Question: Does the plotted quantity increase or decrease?
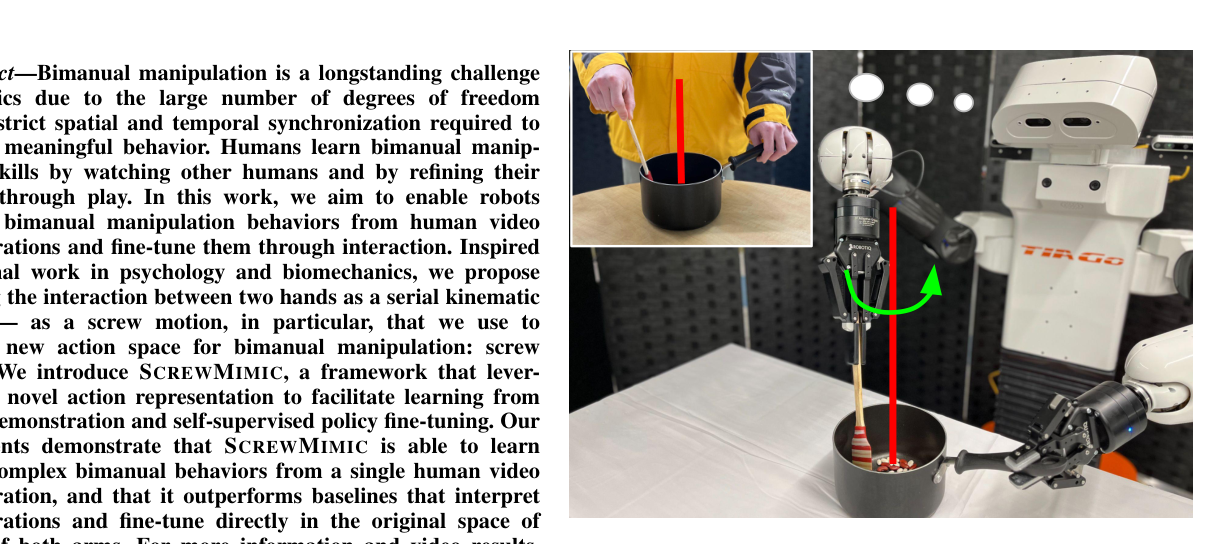
Answer: increasing